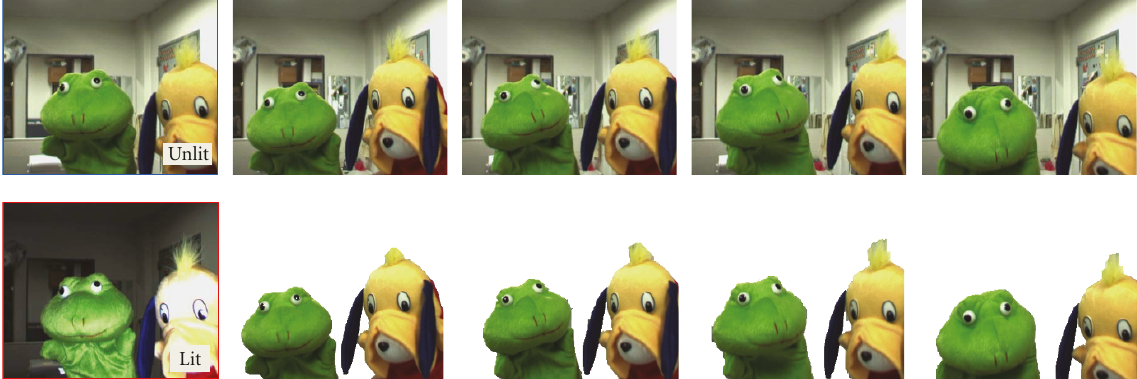
Figure 6: Segmentation of the “Dolls” sequence by the proposed algorithm I. The leftmost column shows a pair of unlit and lit frames, while the other columns show a series of unlit frames and their segmentation